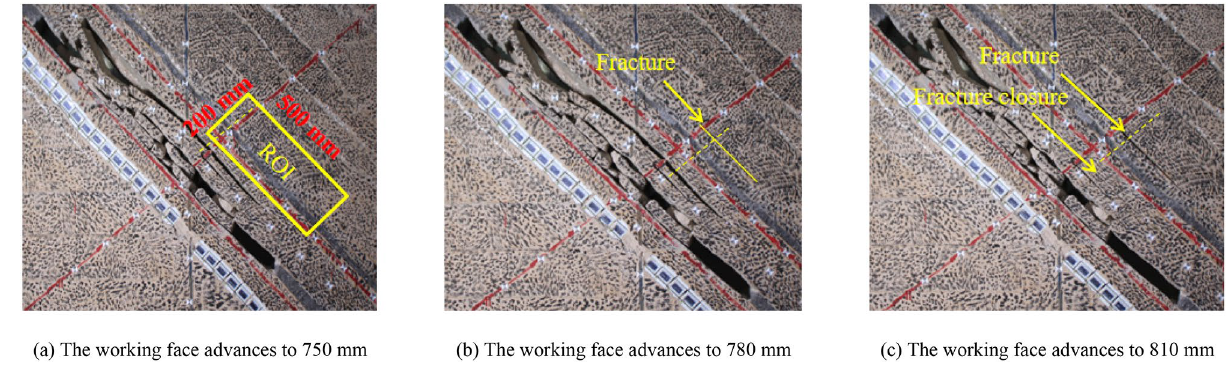
Figure 11. Development characteristics of complex